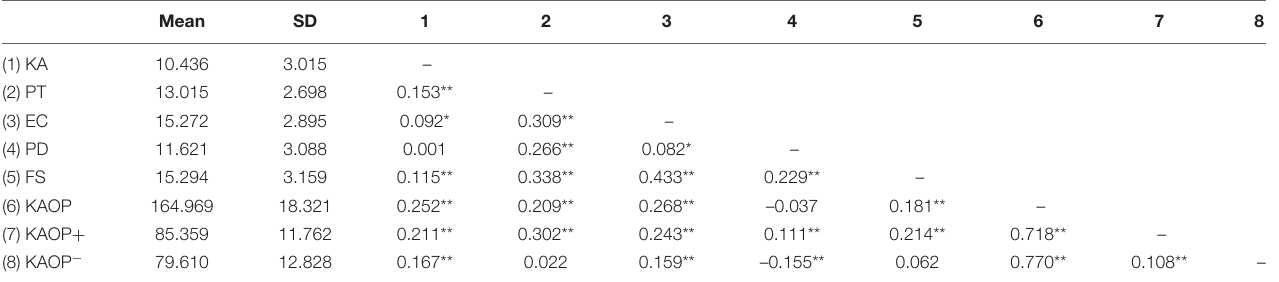
TABLE 1 | Descriptive statistics and correlations of related variables used in the study ( n = 622). Mean